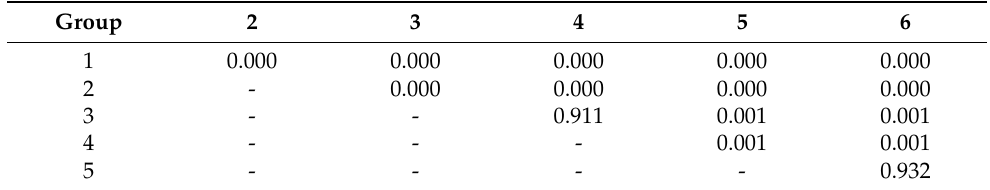
Figure 9. Influence of light-off delay on the average distance between the scanned data and prede- signed preparation data. Table 4. Statistical analysis ( p -value) of the average distance (in µ m) between the scanned data and predesigned data of the tooth preparation with different light-off